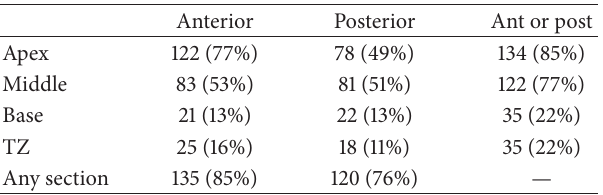
Table 2: Presence of cancer in each location of all 158 radical prostatectomy patients.